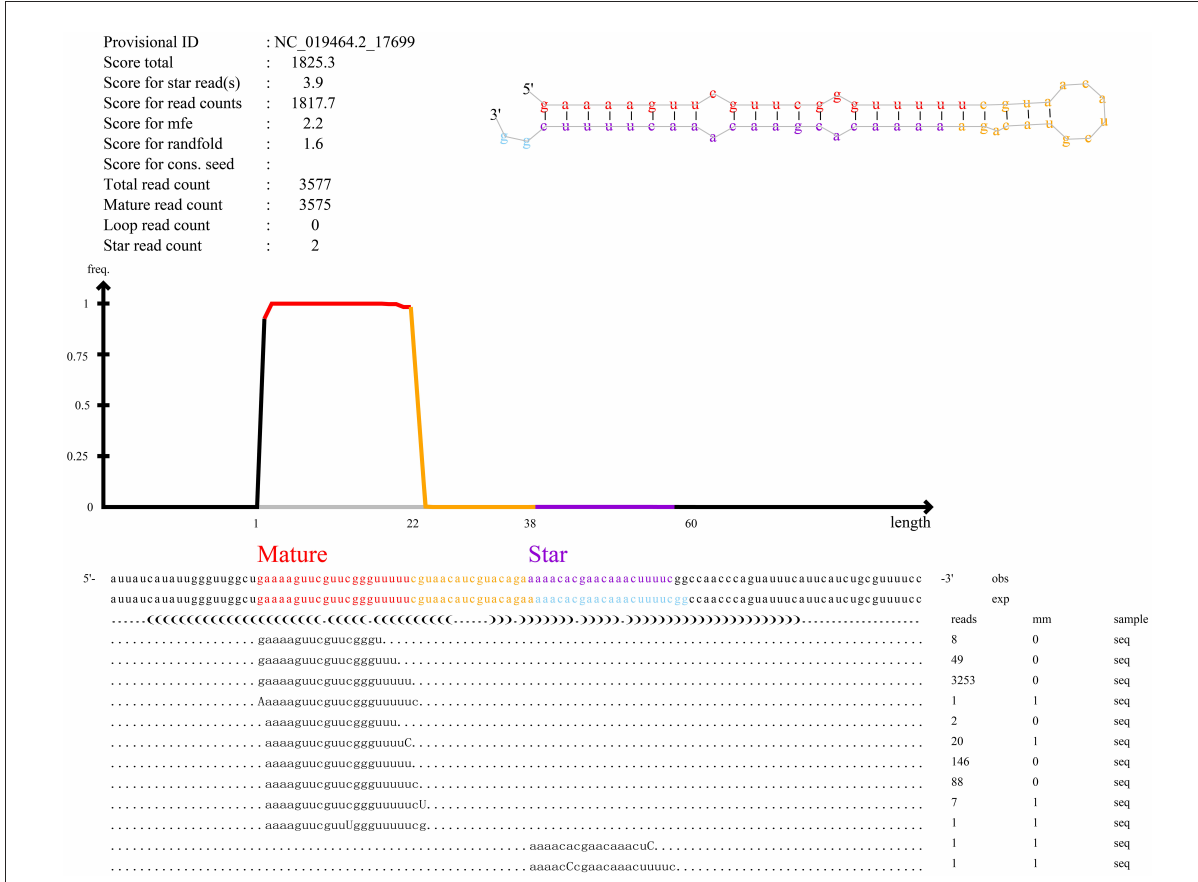
FIGURE3 An example of the miRDeep2 output. The figure illustrates the output for the miRNA of novel_555. The upper part of Figure 3 shows the read count and the total count of each part. The predicted secondary structure of the hairpin is also depicted, with mature (red), star (purple) and circular (yellow) sequences highlighted in different colors. The bottom of the map shows the results of miRNA alignment with predicted precursor sequences on the genome (OBS line) and experimental sequences reported in miRBase (EXP line). For each sequence, the frequency and mismatch with the genome sequence (mm sequence) are given. Mismatches are also highlighted in uppercase